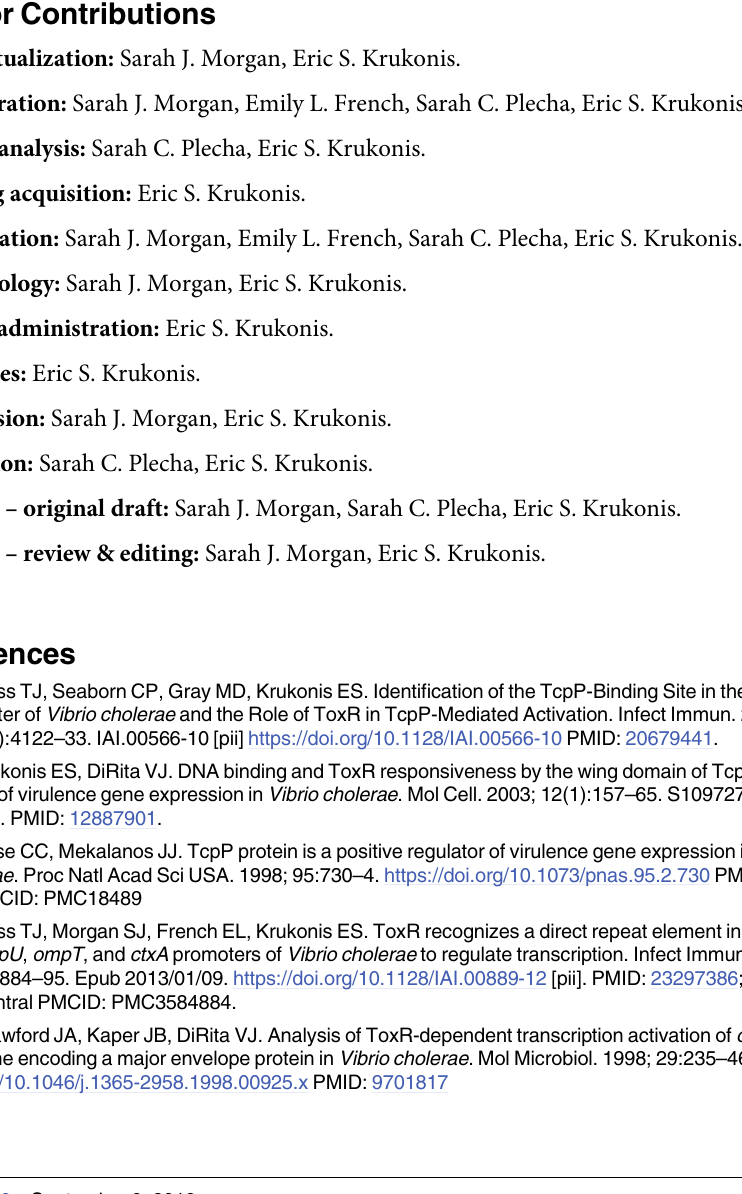
S2 Table. Primers used in this